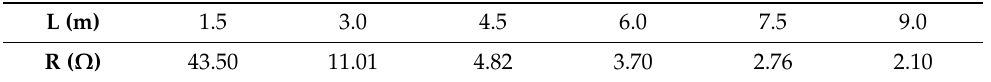
Table 7. Buried rod length L (m) and the corresponding measured grounding resistance R ( Ω ) of the rod located in